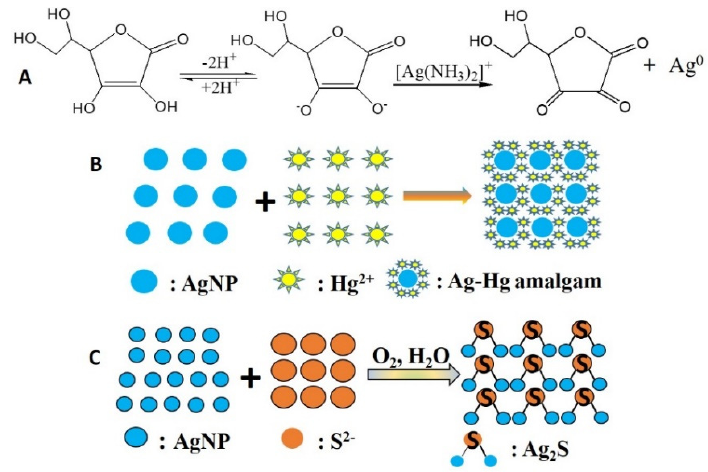
Figure 5. Reaction mechanisms for Vc and Tollens’ reagent ( A ), reaction scheme of AgNPS and Hg 2 + ions ( B ), and AgNPS and S 2 − ions ( C ).